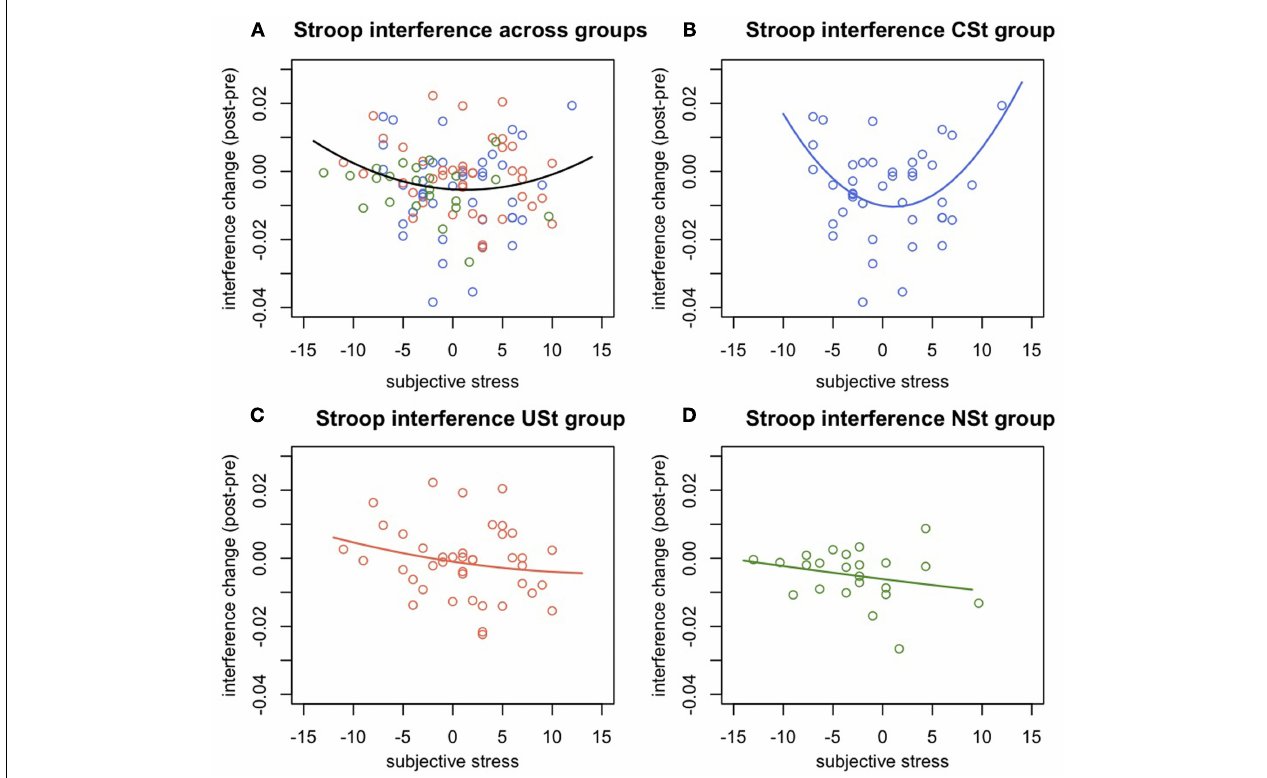
between subjective stress and change in Stroop interference within the group of participants with behavioral control over stressors. (C) Absence of a significant relationship between subjective stress and Stroop interference changes for the group of people exposed to uncontrollable stress, or (D) to